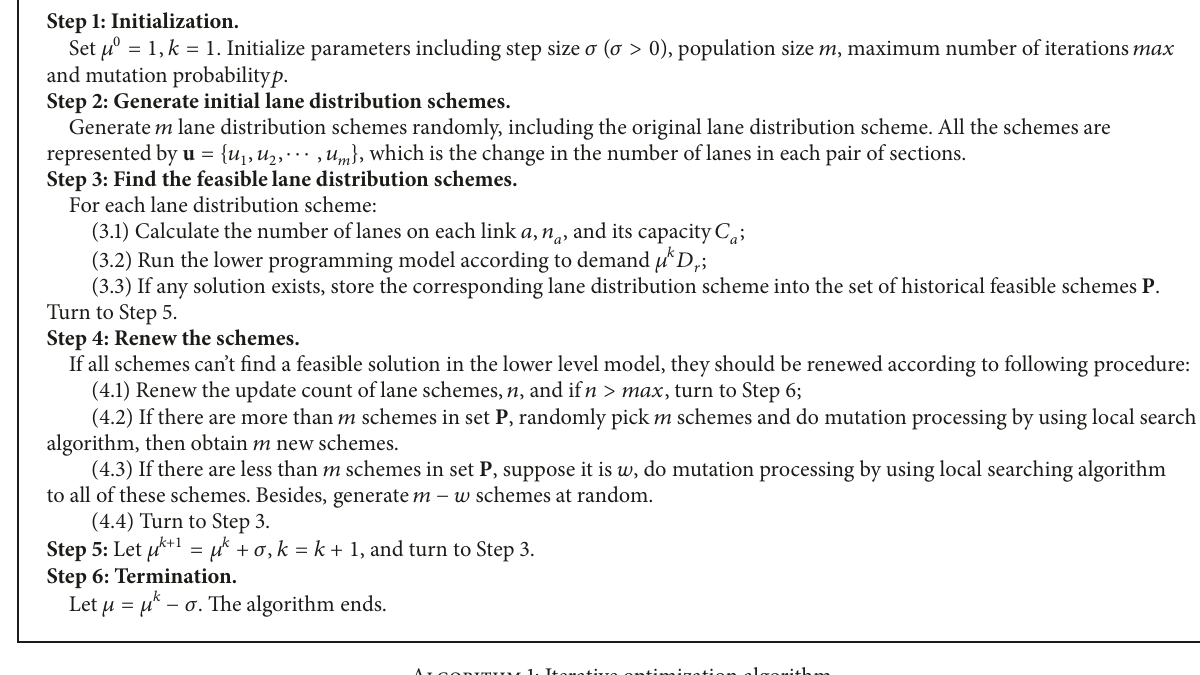
Algorithm 1: Iterative optimization